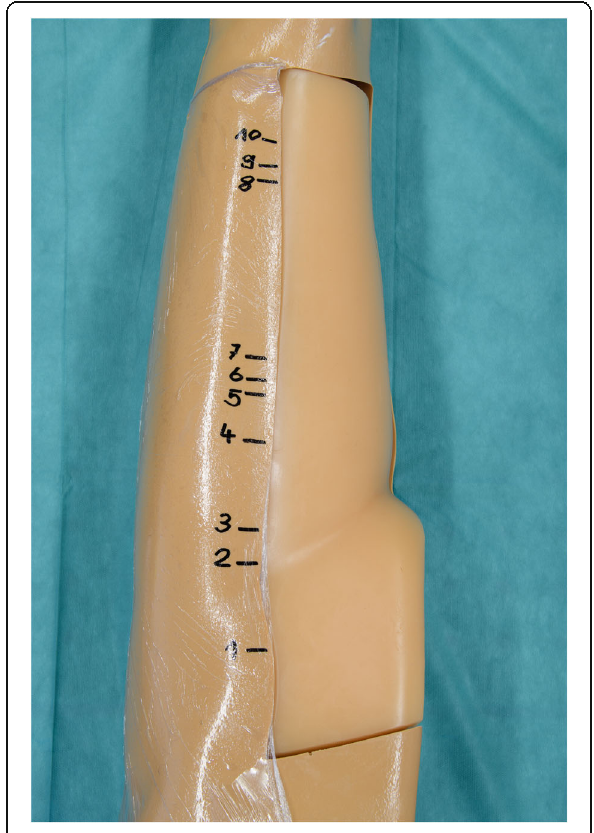
Fig. 2 The prepared leg phantom. Ten out of 20 lesions were marked, so that each operator punctuated the same lesions in the same